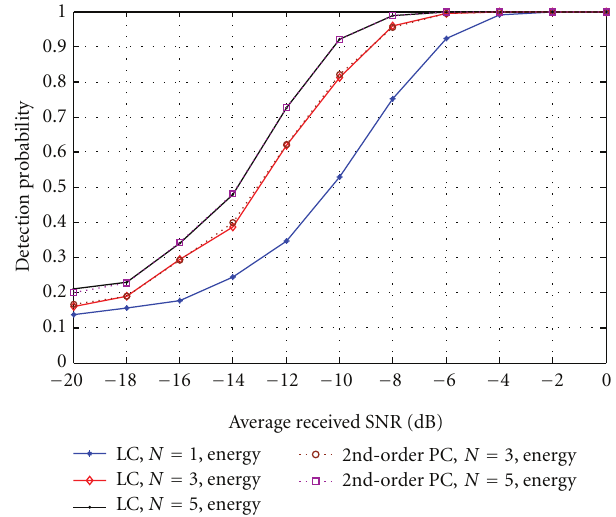
Figure 4: Detection performance for cooperative LC and PC with energy-based feature extraction.